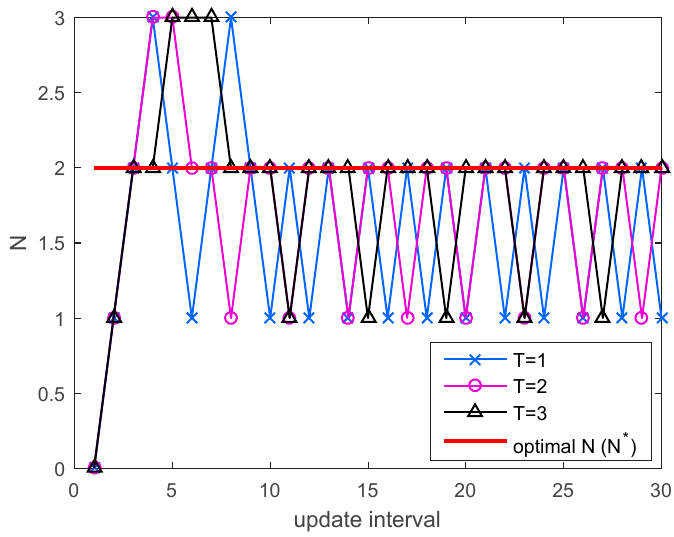
Figure 5. An example of adaptation of N for different value of T in the simulation environments of Figure 4 at SINR = 11 dB.